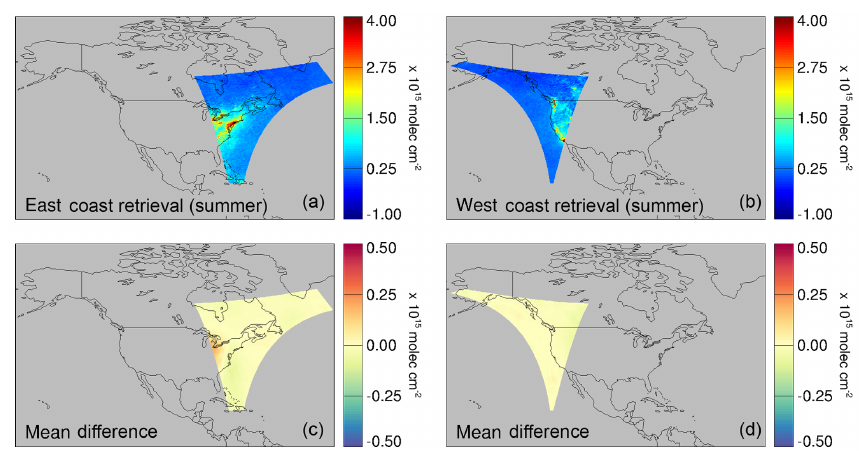
Figure 9. Panels (a, b) show mean July tropospheric NO 2 column densities at 11:30UTC (a, c) and 02:00UTC (b, d) resulting from our TEMPO STS algorithm. Panels (c, d) show absolute difference in the tropospheric NO 2 column between the TEMPO algorithm and the global STS algorithm.